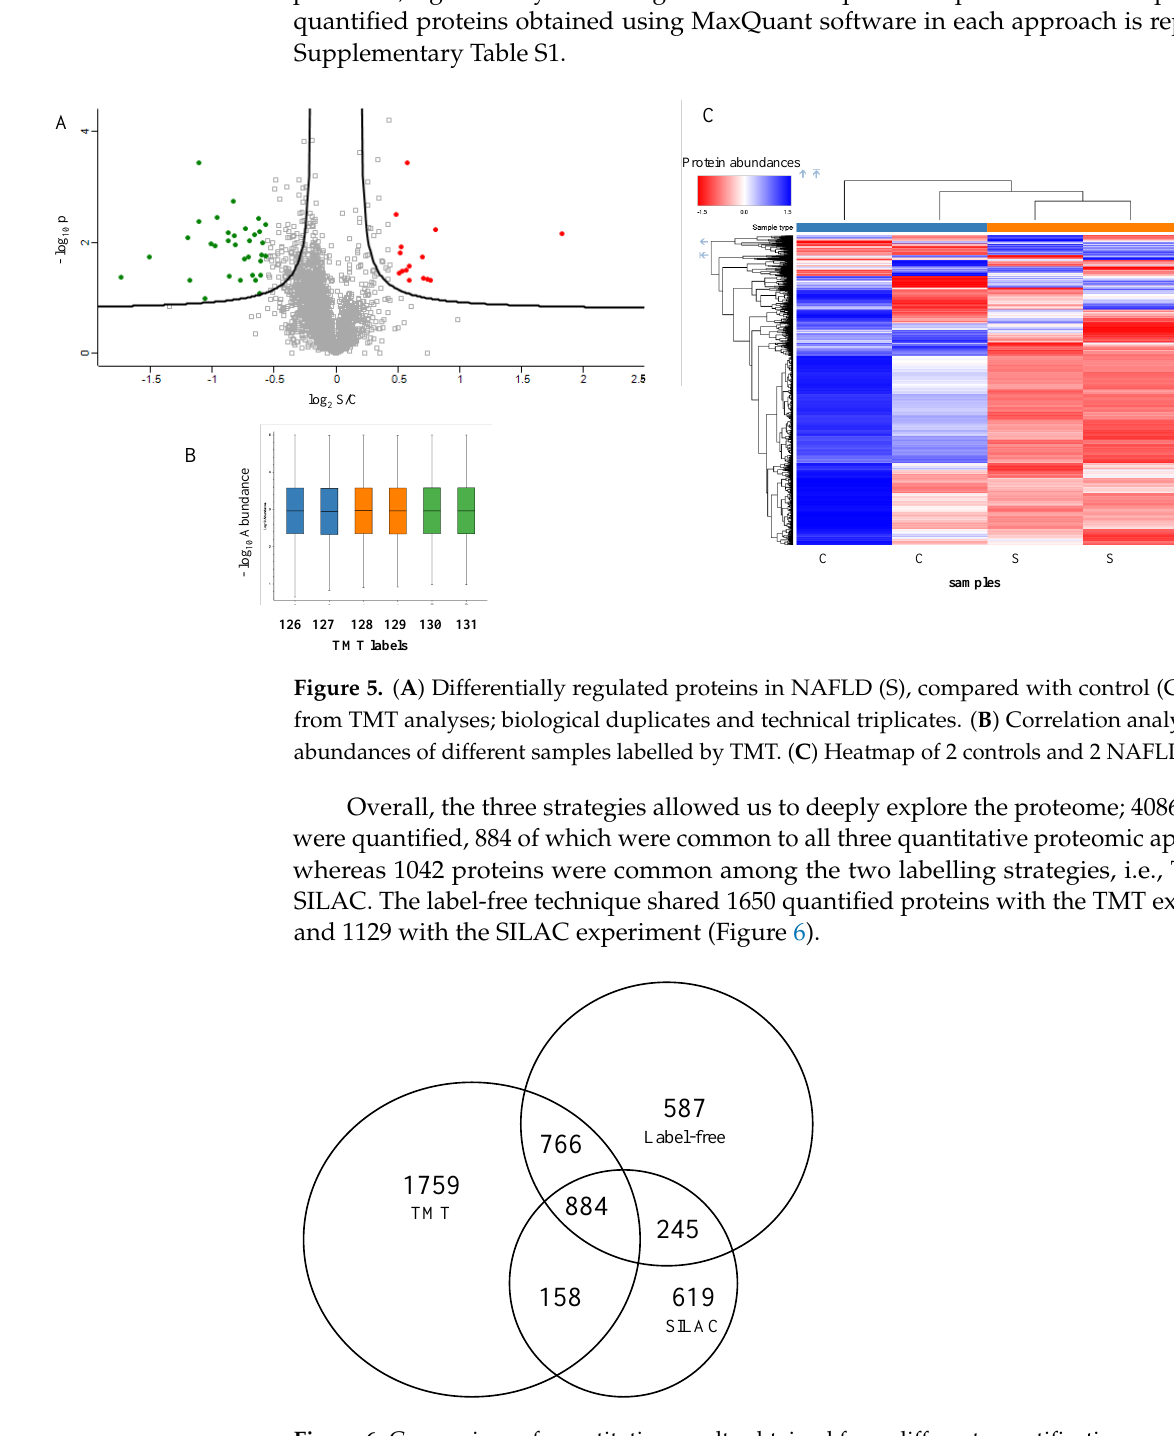
Figure 6. Comparison of quantitative results obtained from different quantification approaches by Venn diagram.